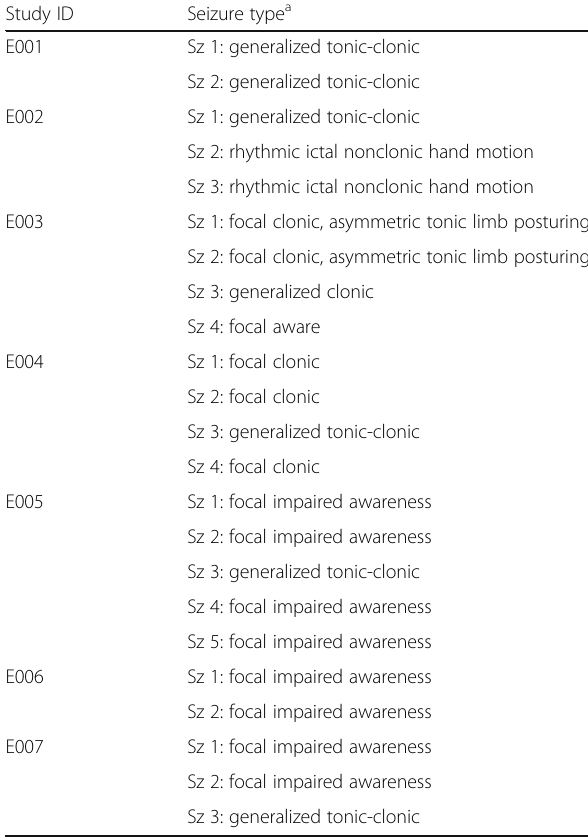
Table 3 Clinical seizure